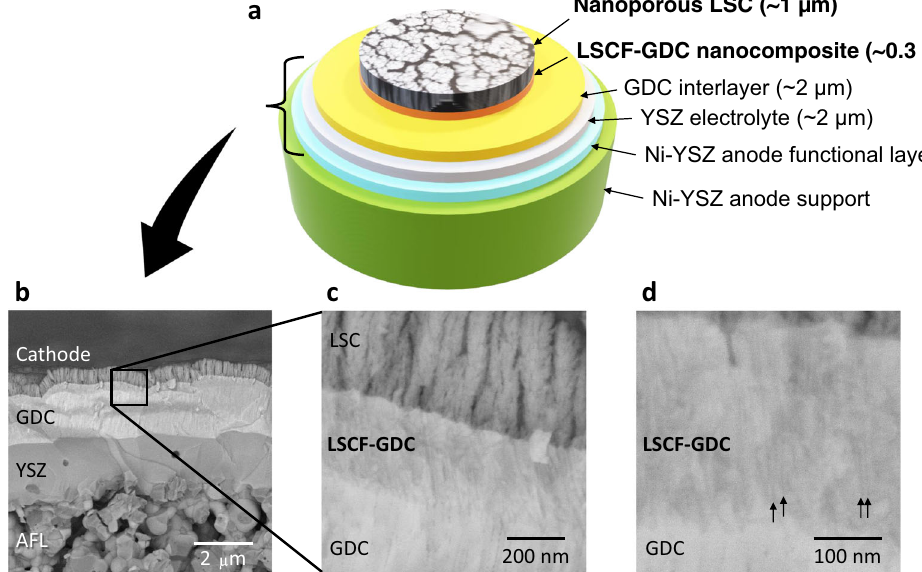
Fig. 5 Nanoengineered cell architecture and microstructural evaluation of the fabricated cell. a Schematic illustration of the nanoengineered cell architecture developed for the anode-supported cell. The anode support, AFL, and electrolyte are fabricated using conventional wet processes such as extrusion and screen-printing methods, whereas the GDC interlayer, LSCF-GDC nanocomposite layer, and nanoporous LSC thin fi lm are all deposited using PLD. b Cross-sectional SEM image of the as-grown fabricated cell showing the details of the AFL, YSZ electrolyte, GDC interlayer, LSCF-GDC nanocomposite layer, and nanoporous LSC thin fi lm. c High-magni fi cation cross-sectional SEM image (the zoomed area is depicted by a square on b ) showing the detailed microstructure of the GDC interlayer, LSCF-GDC nanocomposite, and nanoporous LSC thin fi lm. d High-magni fi cation cross-sectional SEM image showing details of the LSCF-GDC nanocomposite and part of the GDC interlayer as prepared on anode-supported cell. Black arrows indicate dark-contrast stripes pertaining to the LSCF phase in the